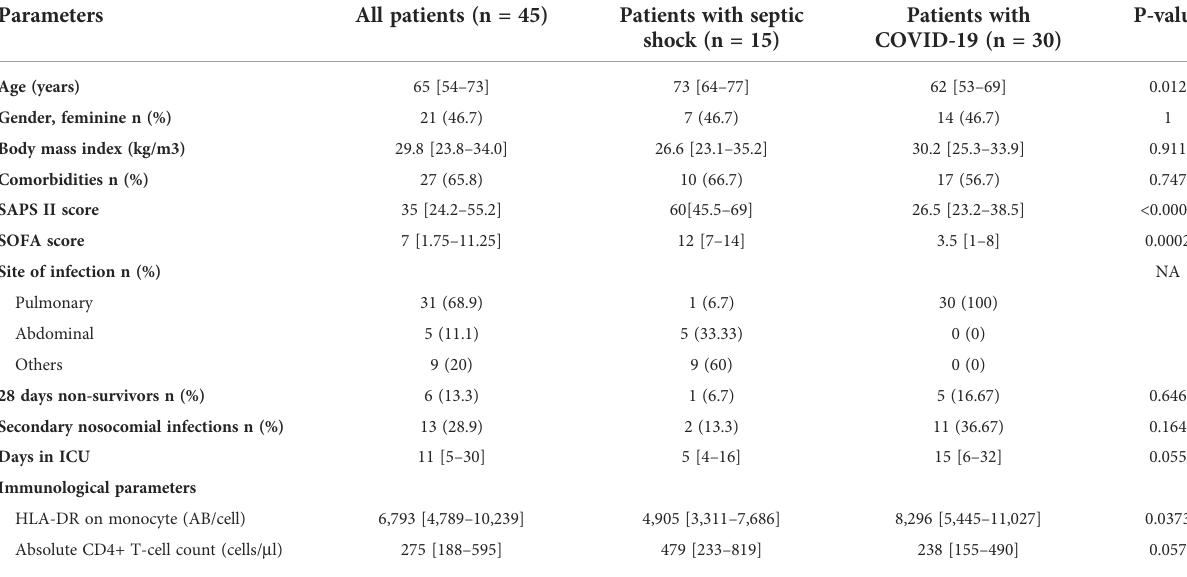
TABLE 1 Demographic, clinical, and immunological data of patients with septic shock and COVID-19. Parameters All patients (n =